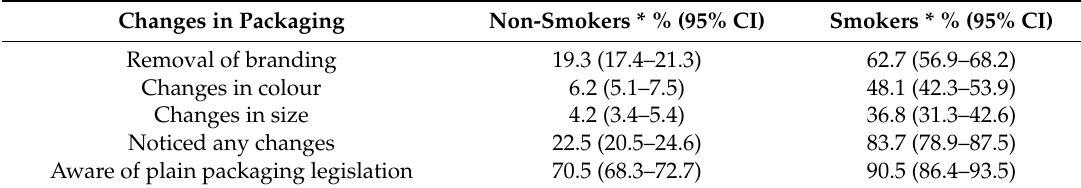
Table 2. Noticing changes in packaging by smoking